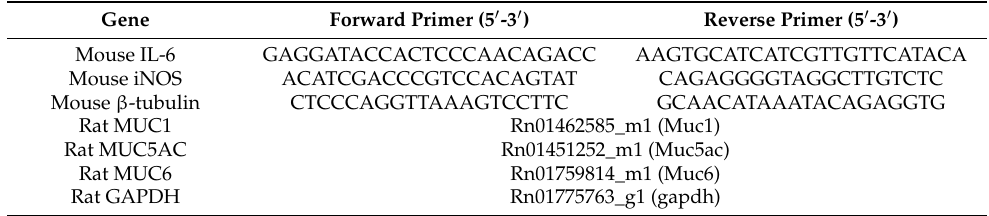
Table 1. The primer sets used for real-time PCR